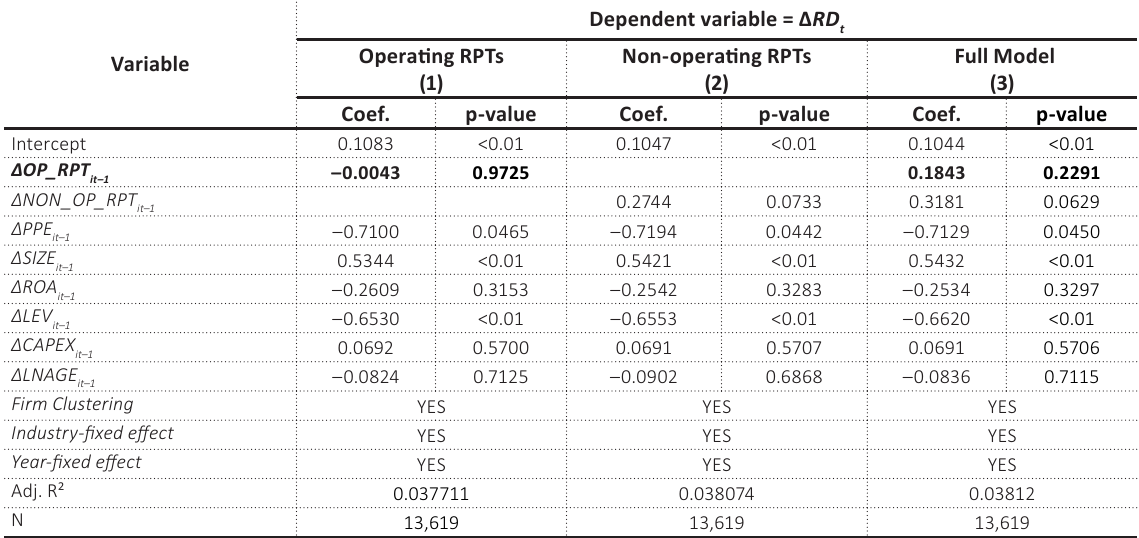
Table 7 (cont.). Robustness test: Changes in RPTs and changes in the firm’s R&D